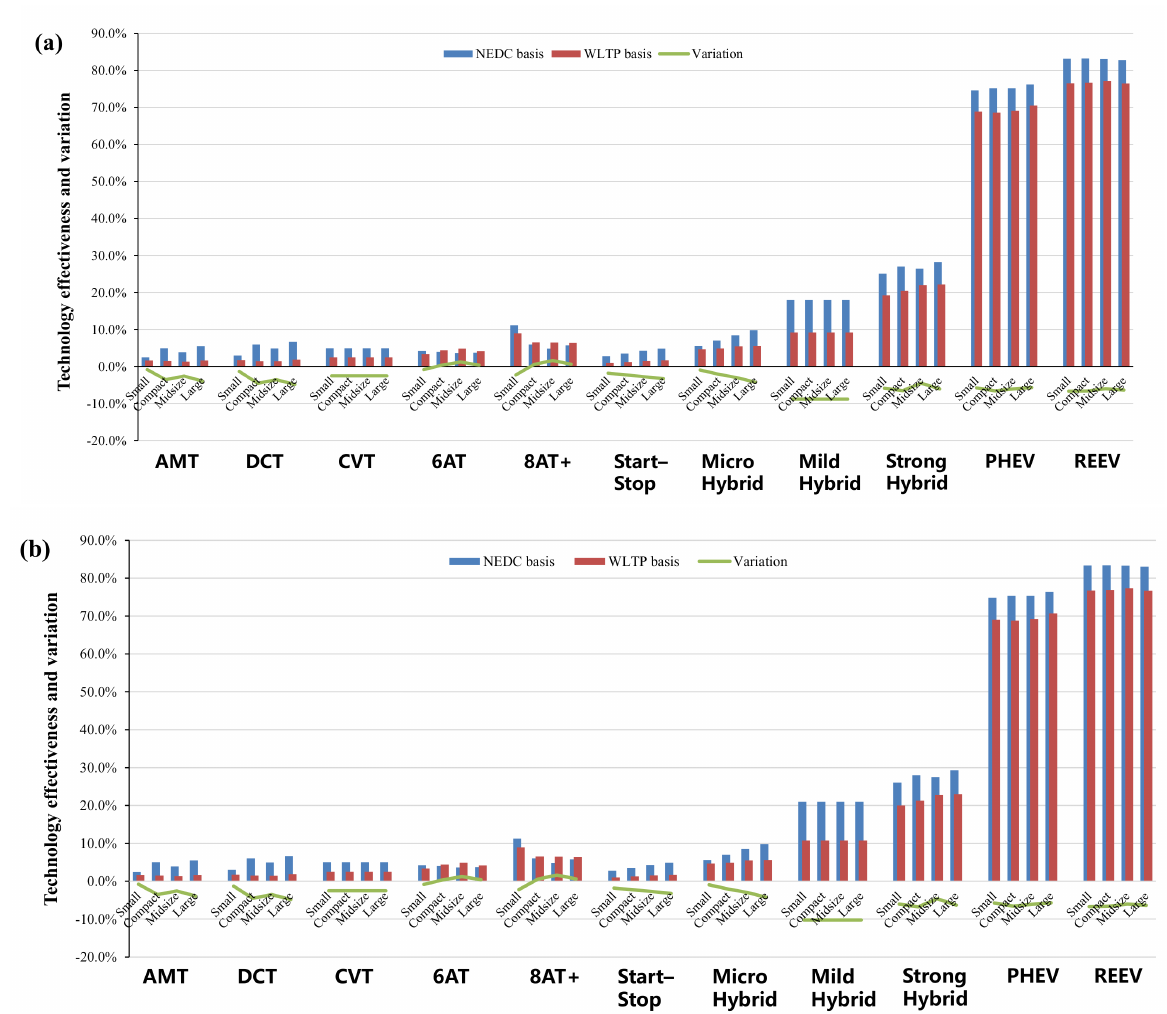
Figure 7. ( a , b ): Comparisons of transmission and electric technologies in 2025 and 2030. We also examined vehicle and accessory technologies, where a high level of lightweight technology (20–30% lightweight rate) applied to large vehicles under the WLTP show in- creased effectiveness compared with that of the NEDC, while the energy–saving effect is decreased for other technologies. Due to the higher speed in the WLTP, the effectiveness of low wind resistance, low rolling resistance, and low drag braking is improved by about 1.2–2.4%, 0.4–1.4%, and 0.1%, respectively. The auxiliary systems efficiency improvement (AUX) and electric power steering (EPS) are faced with decreased effectiveness, and the deterioration of AUX is more obvious with a range of 0.8–6.1%, where the larger the model, the more serious the deterioration will